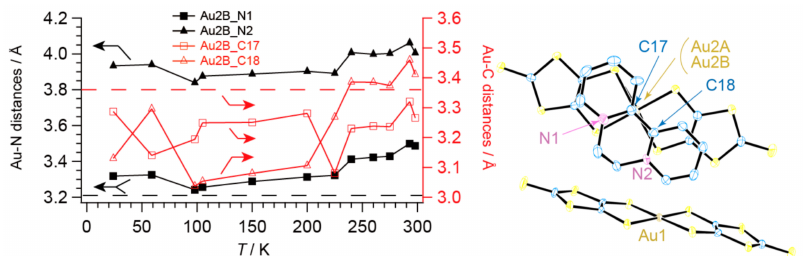
Figure 12. Interatomic distances between Au2B and N or C atoms on BPY. Horizontal broken lines indicate the van der Waals distances of Au–N (black; 3.21 Å) and Au–C (red; 3.36 Å), respectively. Each symbol includes uncertainty (esd) of the distance, which is in the order of 0.01 Å.Reproduced from Ref. [13] with permission from the Royal Society of Chemistry.